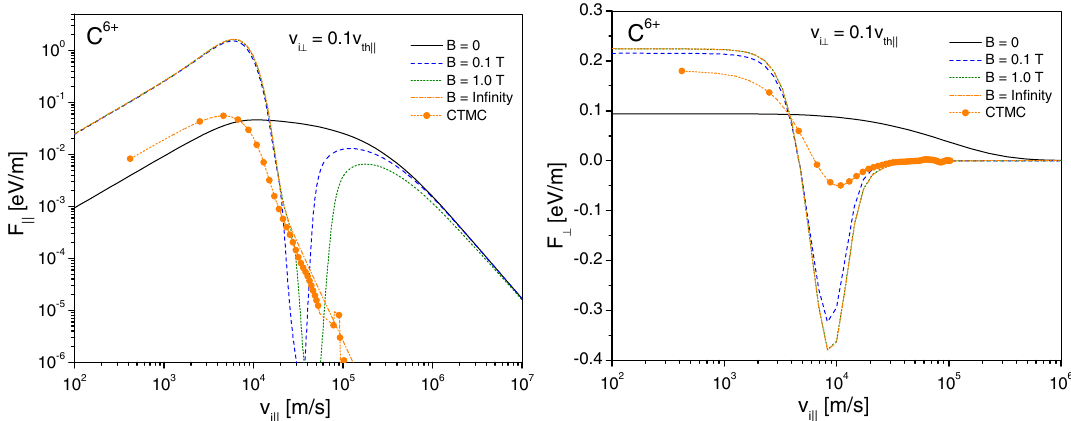
FIG. 1. Longitudinal ( (cid:1) F k , left panel) and transverse ( (cid:1) F ? , right panel) cooling forces (with minus signs and in eV = m ) for C 6 þ fully stripped ions as a function of the ion velocity v forces (18) and (19) are calculated for (cid:2) 0 ¼ 10 (cid:1) 9 m (see Appendix B for details) and for an electron beam with n T ? ¼ 0 : 11 eV , and T k ¼ 0 : 1 meV in a magnetic field of B ¼ 0 (solid line), 0.1 T (dashed line), 1 T (dotted line), and B ¼ 1 (dash-dotted line). The CTMC results for the B ¼ 1 case are shown by the filled circles. Note that in the right panel the transverse force for B ¼ 0 is increased by a factor 10 3 .